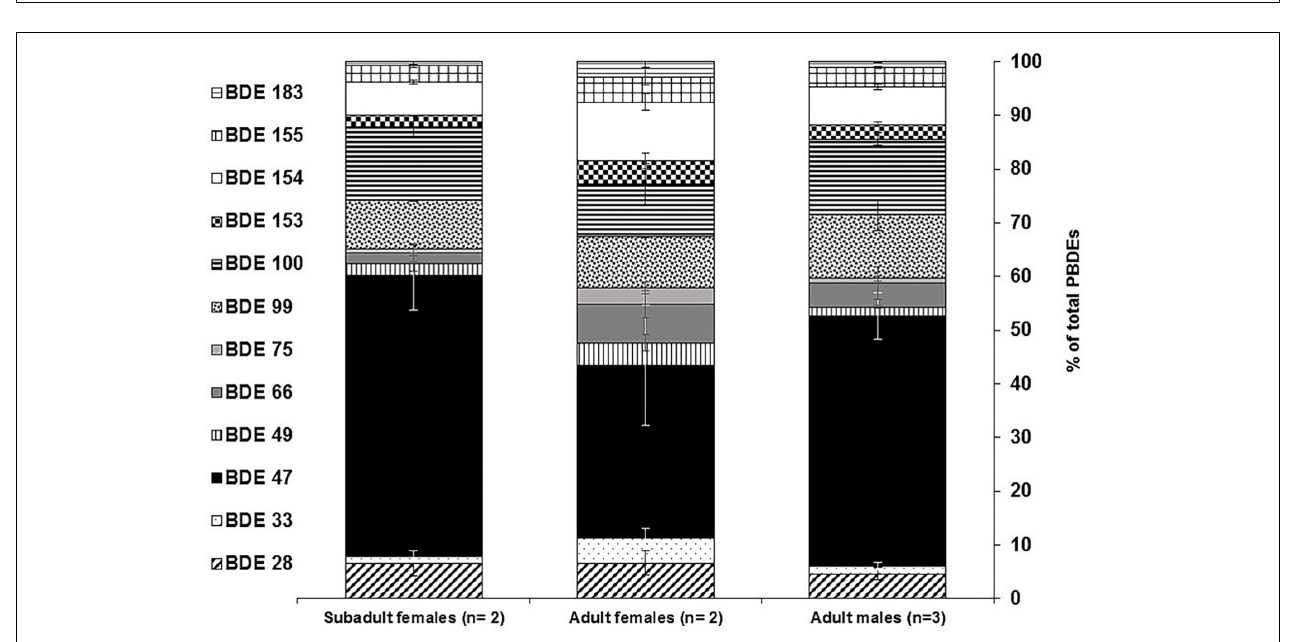
FIGURE 4 | Composition patterns of PBDE congeners relative to total PBDEs in blubber samples form bottlenose dolphins of the El Morro Mangrove Wildlife Refuge, and Posorja Port, Gulf of Guayaquil, Ecuador. BDE 47 contributed (black bars) to most of the PBDE composition.